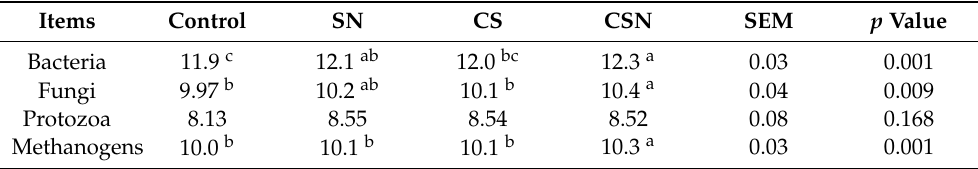
Table 5. Effects of sodium nitrate (SN), cysteamine hydrochloride(CS), and combination of CS